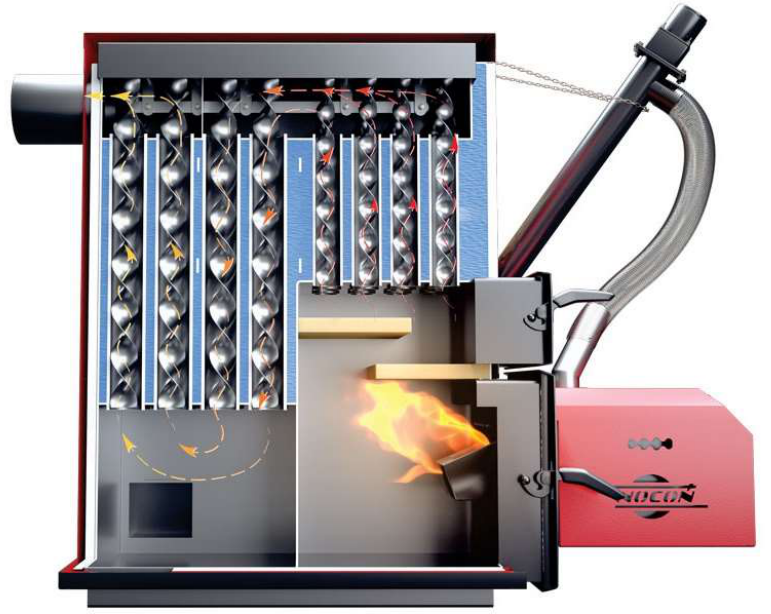
Figure 1. Cross section of the solid fuel boiler tested [50].